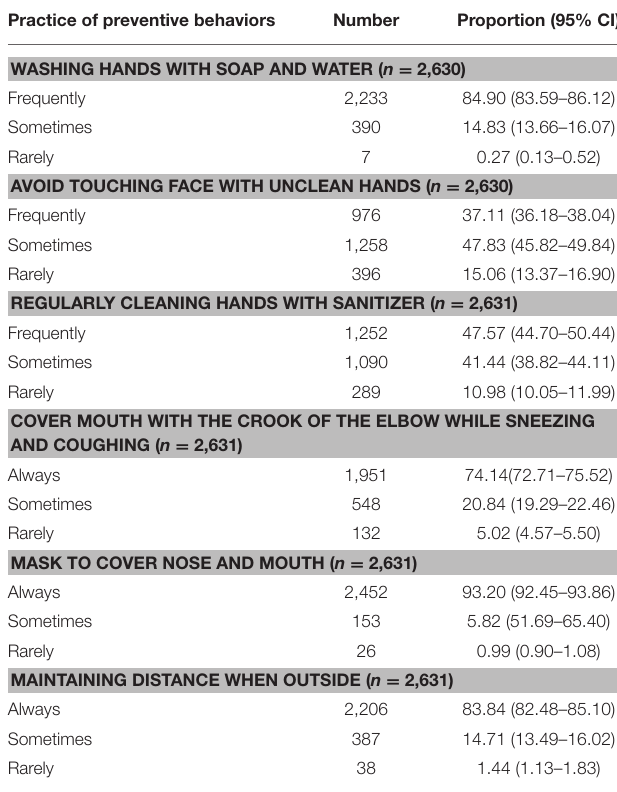
All the Confidence Intervals (CIs) were calculated with the help of robust standard error estimation technique accounting for clustering for sampling zones. “n” represents the number of completed responses for respective